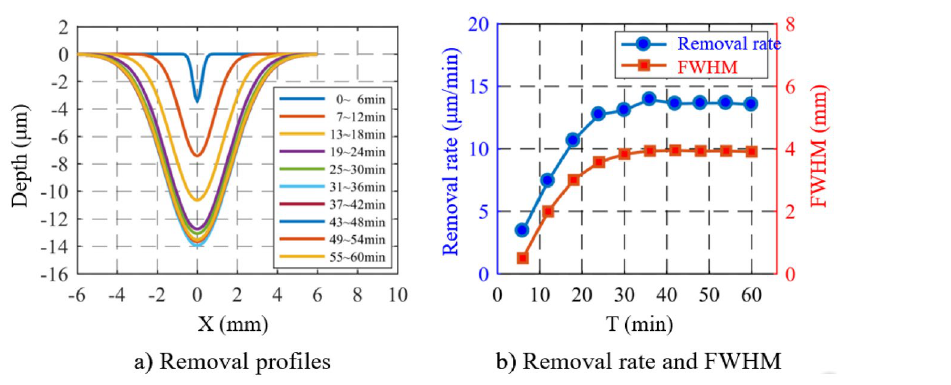
Figure 8. Effect of processing time on removal rate and